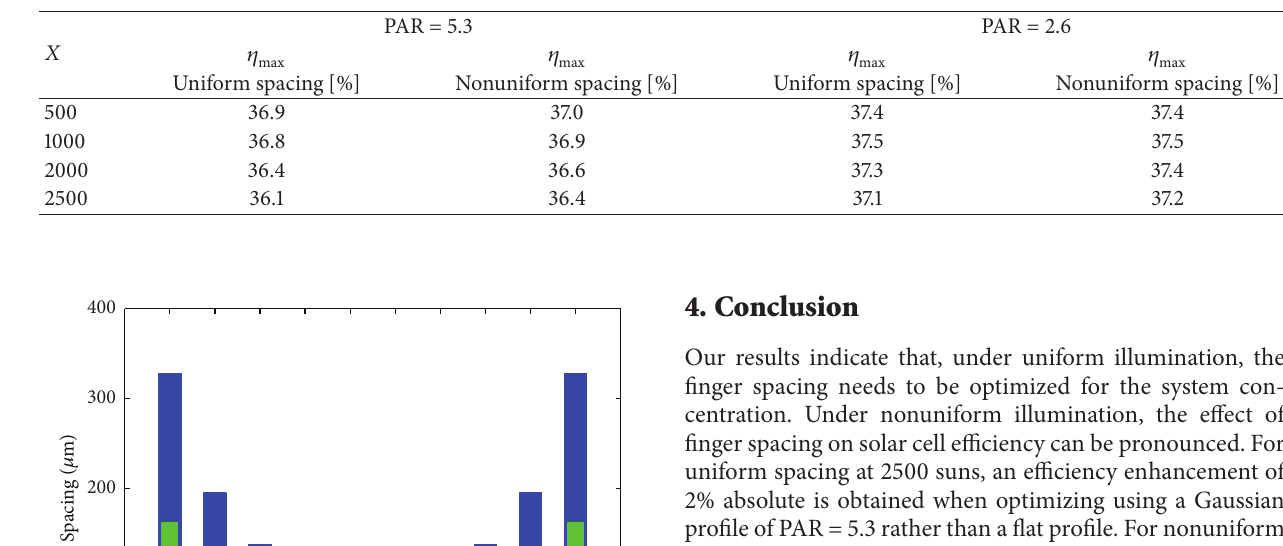
Table 2: Maximum efficiency ( 𝜂 max ) comparison with uniform and nonuniform spacing under PAR = 5.3 and PAR = 2.6 at various concentrations ( 𝑋 ).